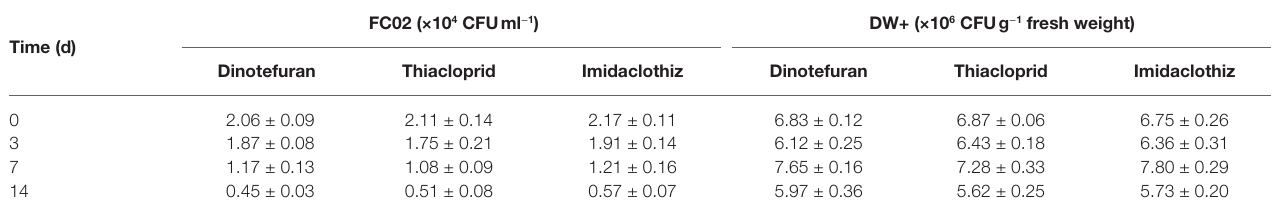
TABLE 5 | Persistence of inoculated bacteria in the FC02 and DW+ treatments.